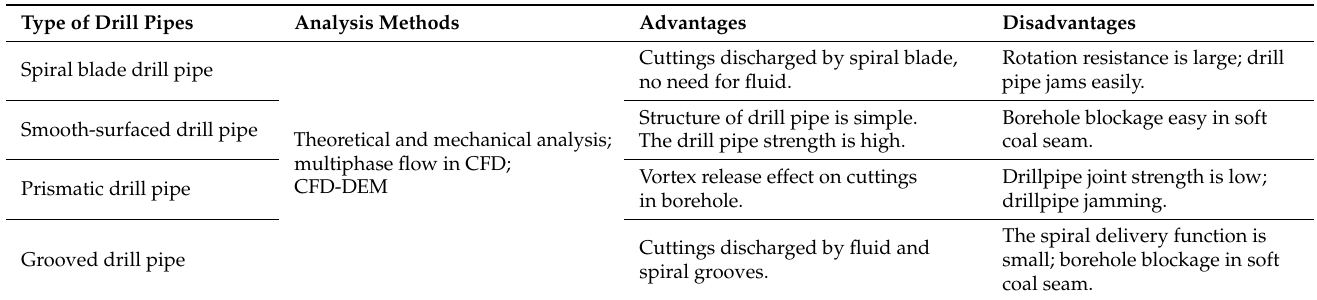
Table 1. Analysis methods for a drill pipe’s working mechanism and drill pipes’ advantages and